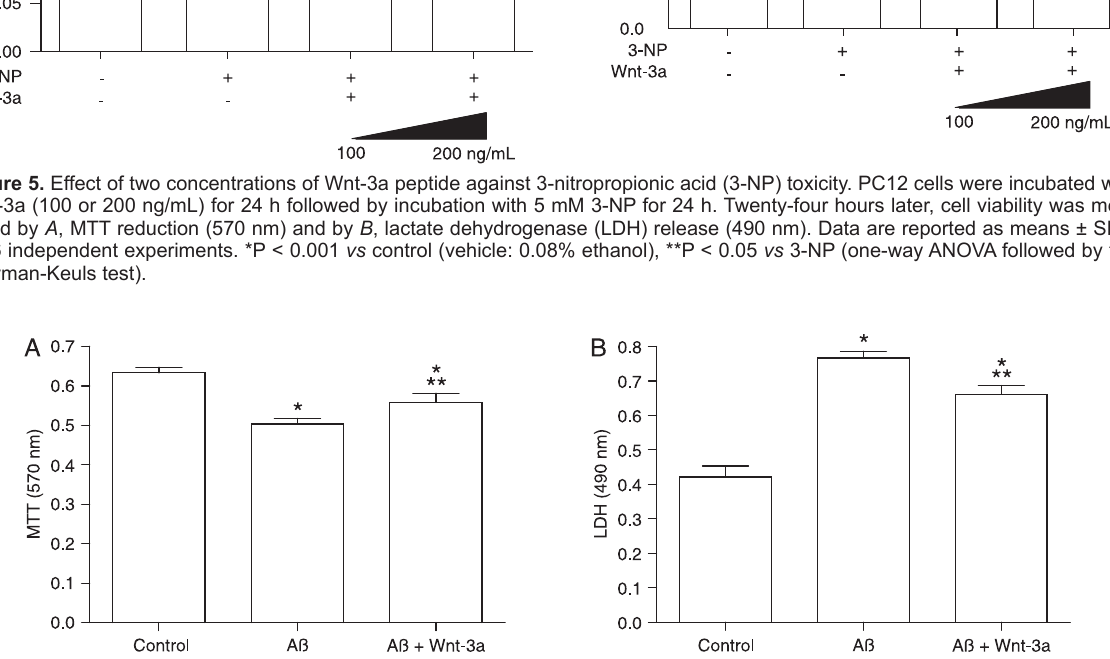
Figure 6. Effect of recombinant Wnt-3a protein on loss of cell viability induced by Aβ 25-35 . PC12 cells were incubated with Wnt-3a (100 ng/mL) for 24 h followed by 50 µM Aβ 25-35 for 24 h. Twenty-four hours later, cell viability and protein expression were evaluated by A , MTT reduction (570 nm) and by B , lactate dehydrogenase (LDH) release (490 nm) assays. Data are reported as means ± SEM for 6 in- dependent experiments. *P < 0.01 vs control (vehicle: PBS); **P < 0.05 vs Aβ (one-way ANOVA followed by the Newman-Keuls